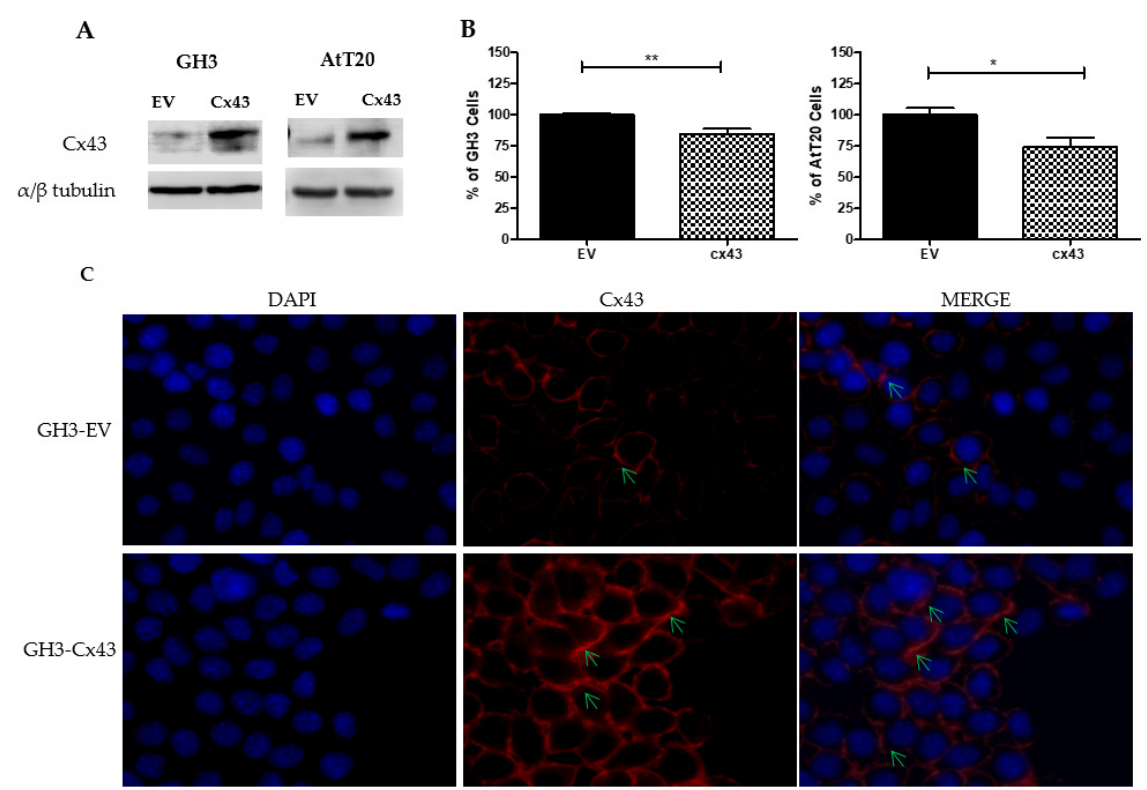
Figure 2. Effect of connexin 43 overexpression in GH3 and AtT-20 cell lines. ( A )—representative Western blot of Cx43 in GH3 and AtT-20 cells that were transfected with Cx43 and empty vector (EV). ( B )—Graphic representation of the number of cells in GH3-Cx43 and AtT-20-Cx43 compared with the controls GH3-EV and AtT-20-EV, respectively. The data are presented as the mean ± SEM and representative of at least three experiments that were performed in duplicate (calculated using Mann–Whitney U-test). * represents significant differences (0.01 ≤ p < 0.05), ** represents very significant differences (0.001 ≤ p < 0.01). ( C )—Immunofluorescence of Cx43 (red) in GH3-EV and GH3-Cx43 cells, nuclear staining with DAPI (blue), at 400x magnification. The green arrows indicate the